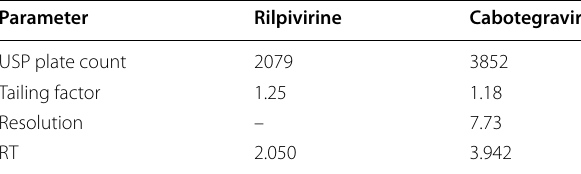
Table 2 System suitability